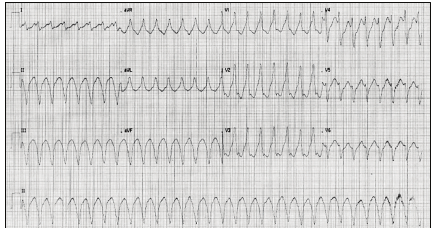
Figure 2: Monomorphic VT during hospital stay on day 4 of MI. It occurred after successful revascularisation without any evidence of ongoing ischemia or metabolic derangements.